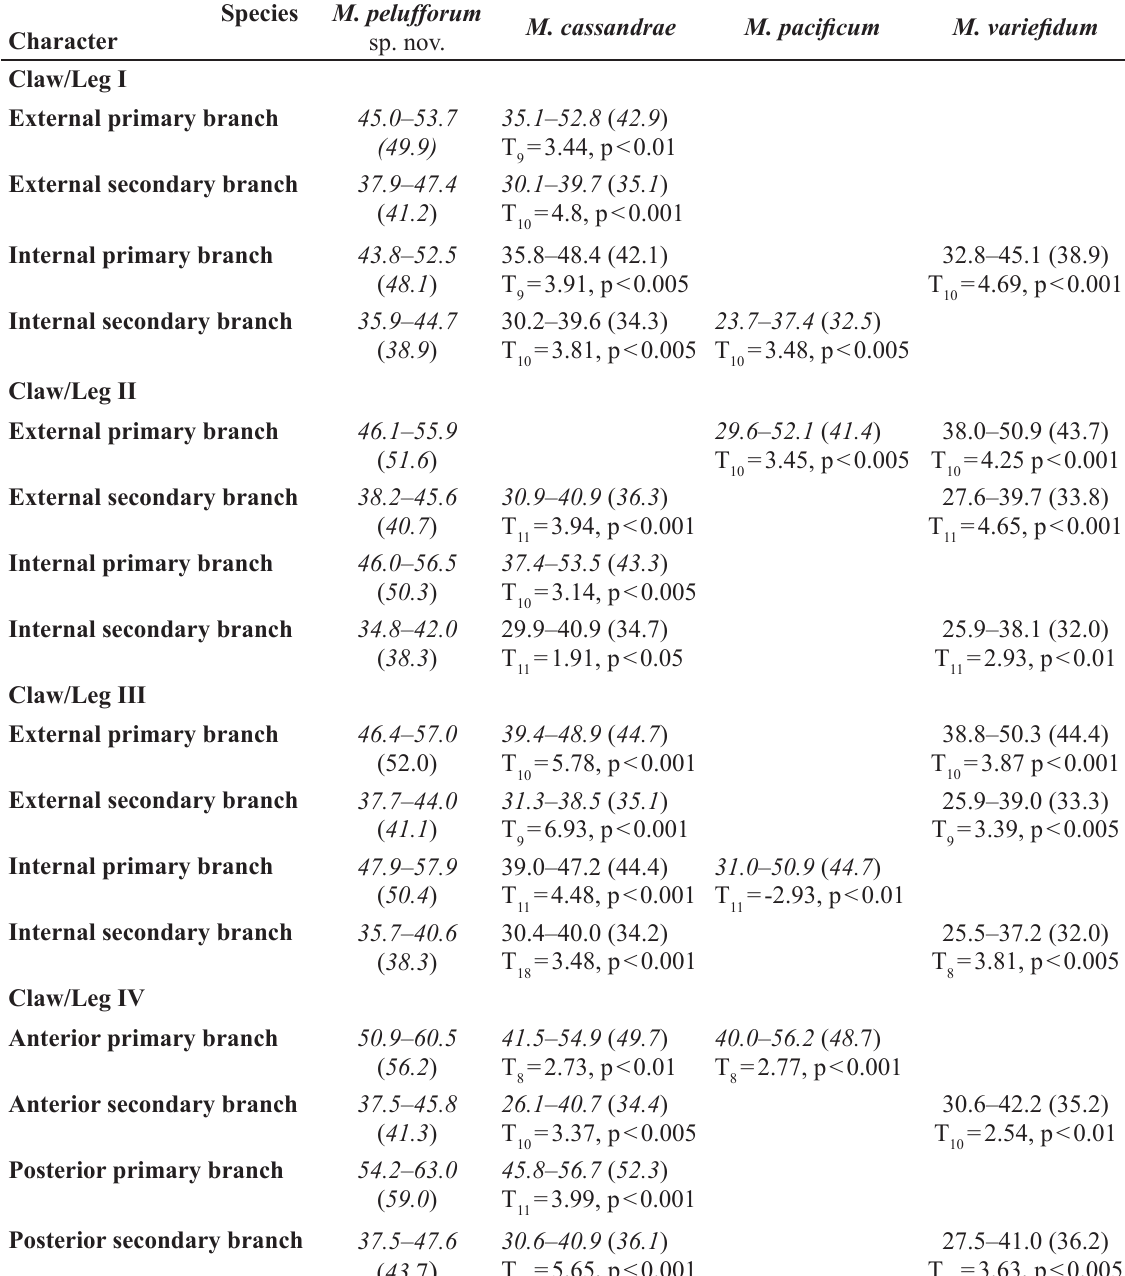
Table 5. Statistically significant differences (through one-side Student t -tests) of overlapping pt ranges of claw heights between young specimens of Milnesium pelufforum sp. nov. and the similar